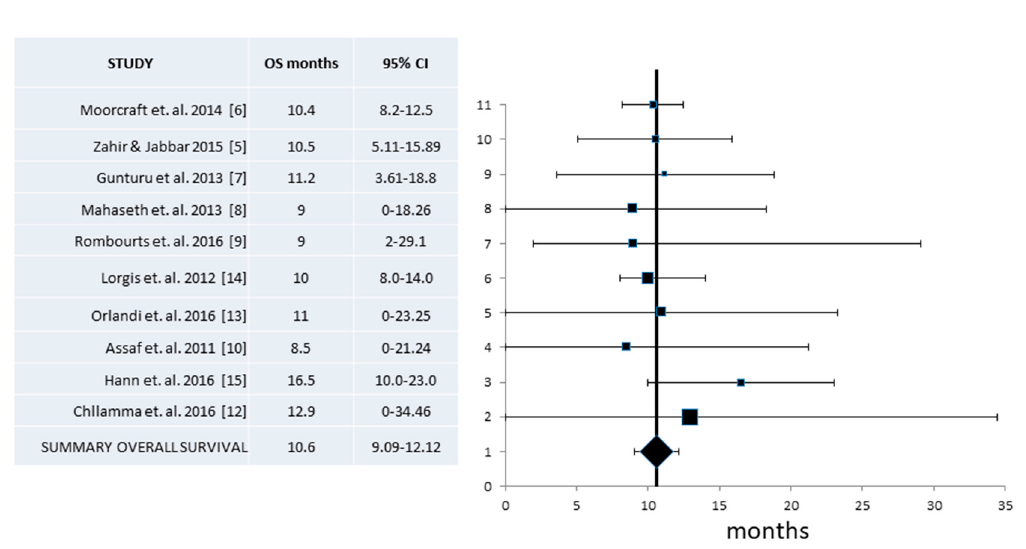
Figure 5. Pooled analysis of Overall Survival (OS) and 95% Confidence Intervals (CI) from published series. Ten studies with a total of 332 patients that provided information for the OS were included. Pooled OS derived was 10.6 months (95% CI 9.09–12.12 months).